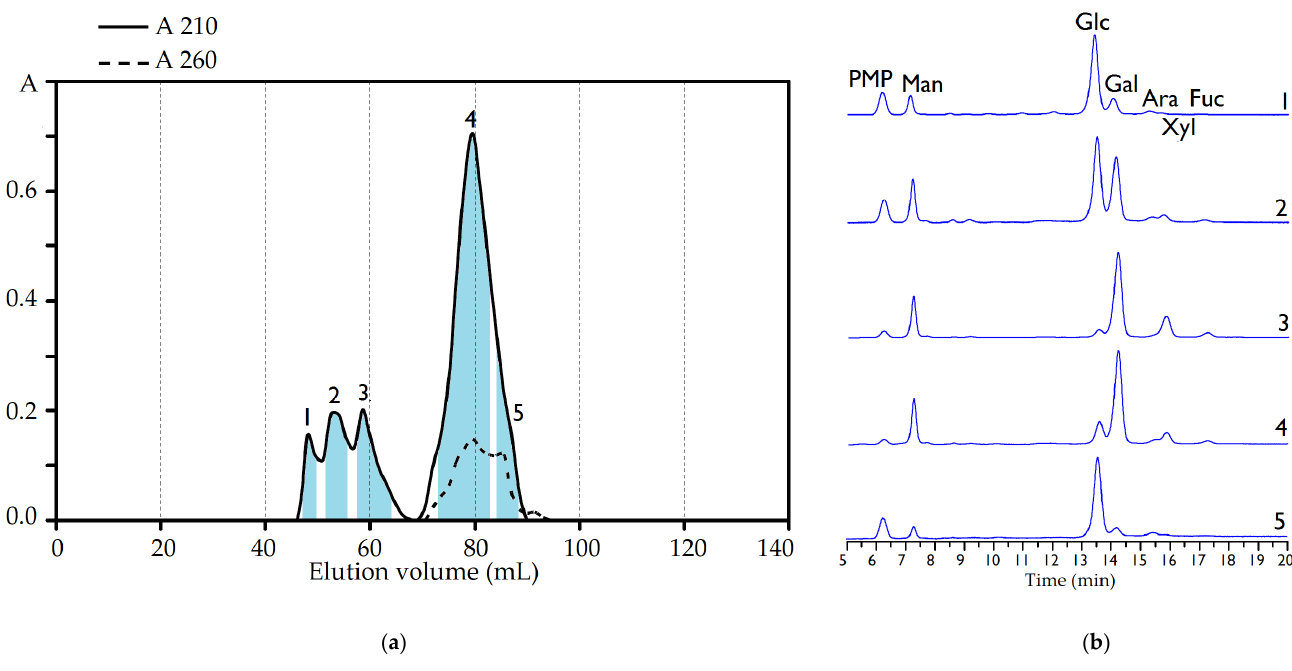
Figure 2. UV ( a ) and FTIR spectra ( b ) of IRP polysaccharide.